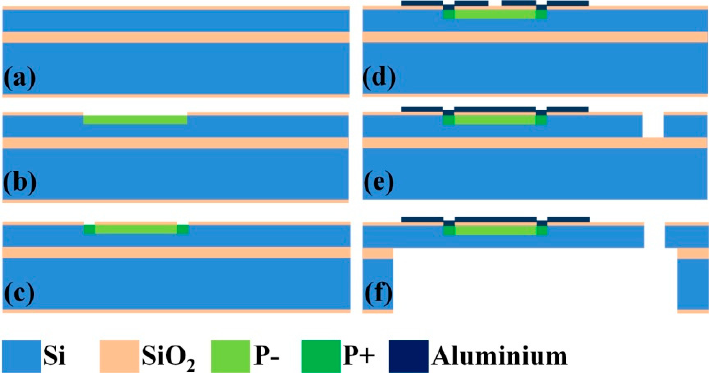
Figure 5. Schematic of the main steps to fabricate the MEMS device: ( a ) thermal oxidation; ( b ) p − doped; ( c ) p+ doped and contact hole; ( d ) interconnects and pads; ( e ) front side inductively coupled plasma (ICP); and ( f ) structure release.